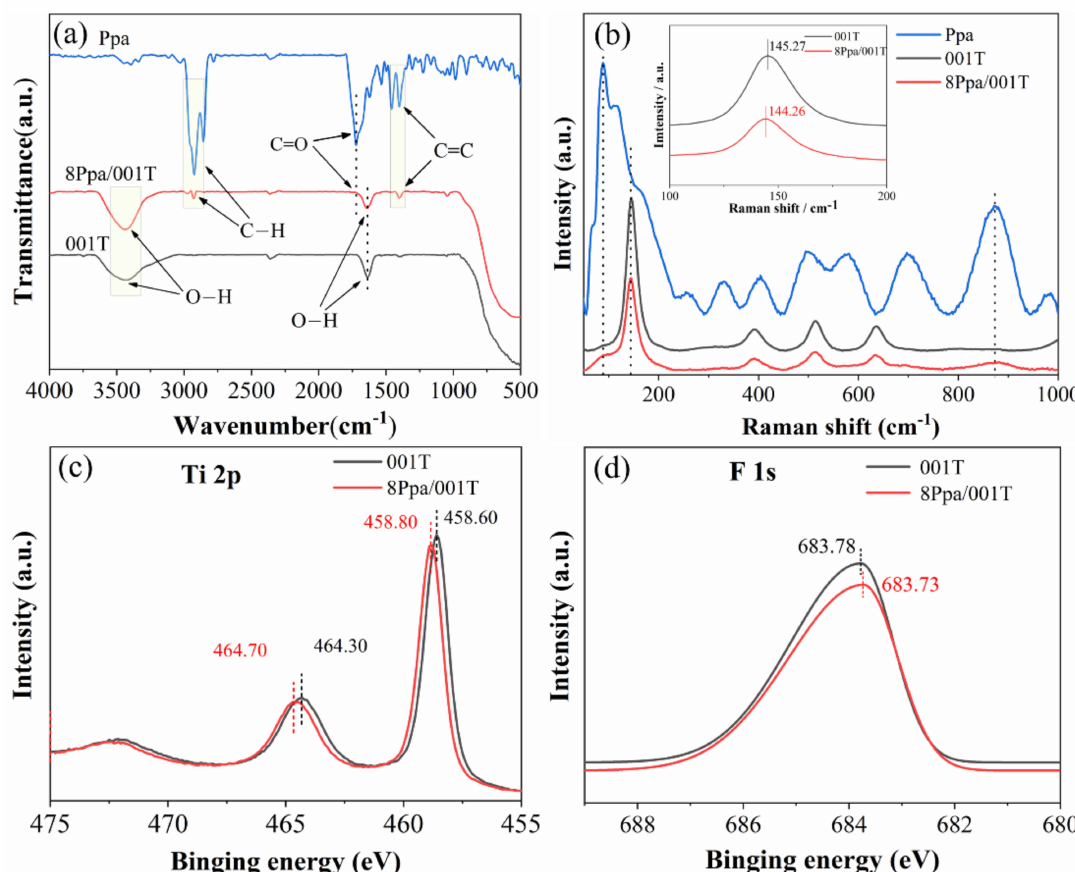
Figure 3. FT-IR ( a ) and Raman spectra ( b ) of Ppa, 001T, and 8Ppa/001T; and XPS spectra for Ti 2p of 001T and 8Ppa/001T ( c ) and for F1s of 001T and 8Ppa/001T ( d